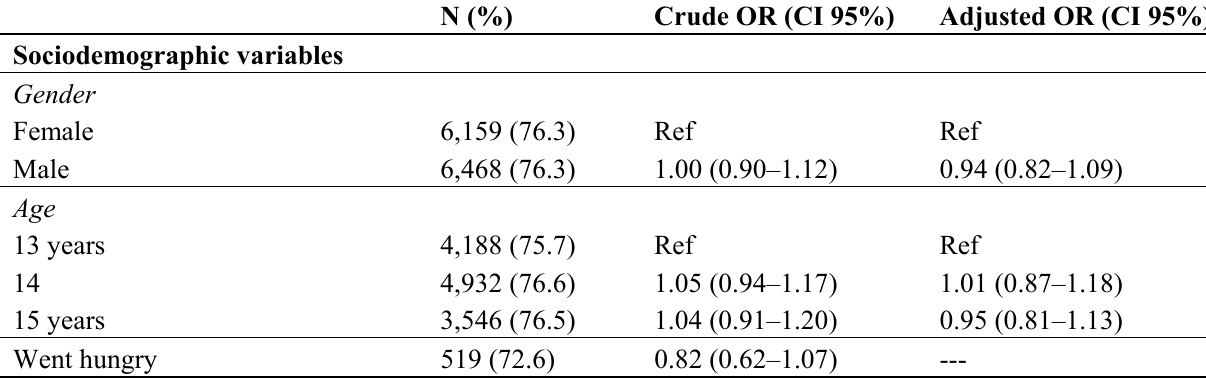
Table 3. Univariate and multivariate logistic regression of inadequate fruits and vegetable consumption, GSHS